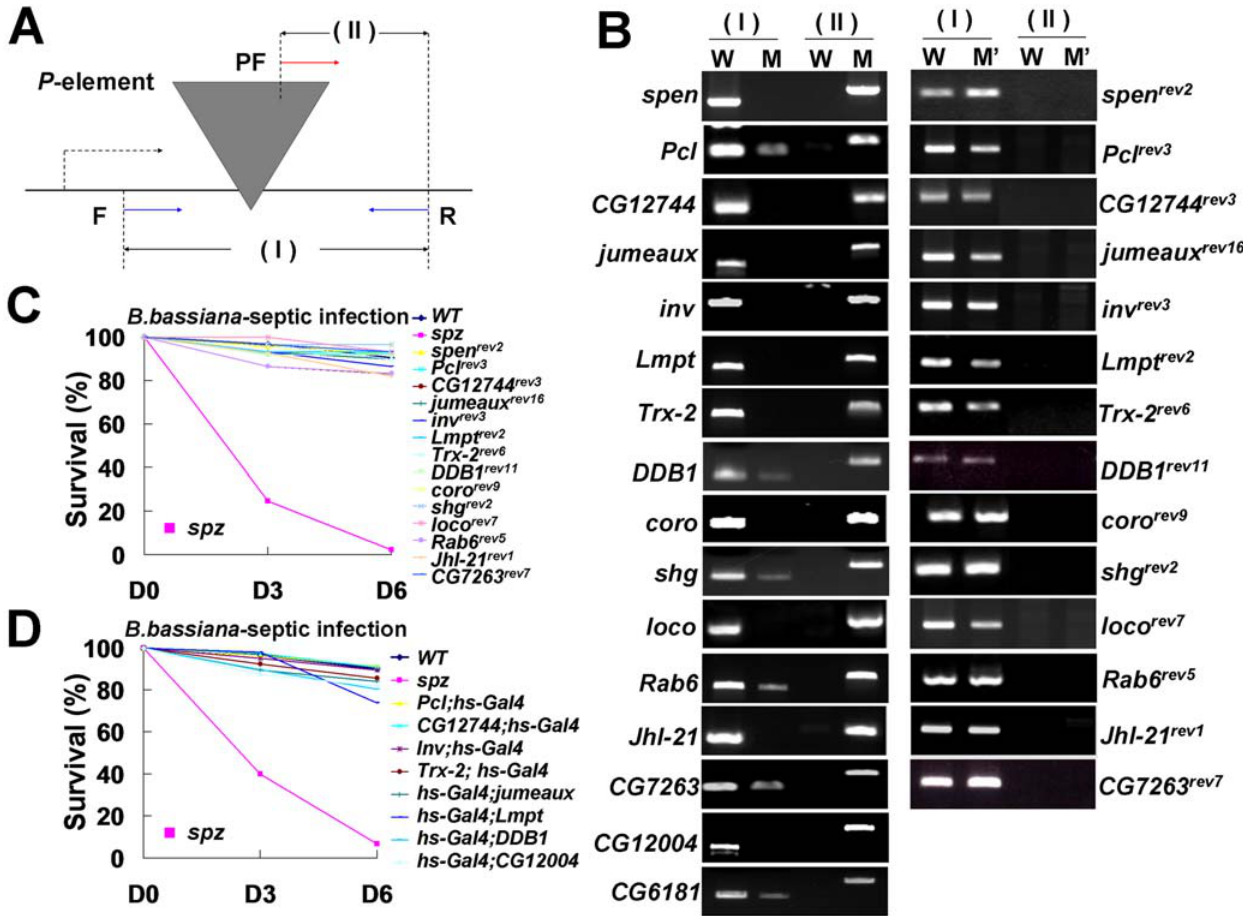
Figure 2. Confirmation of precise excision lines from P -element inserted mutant flies. (A) Relative positions and orientations of PCR primers used to confirm the position of P -element insertions and their precise excision. Primers F and R are complementary to the genomic DNA surrounding each P -element insertion site, while the PF primer is complementary to the P -element. PCR fragments amplified by the gene-specific primers (F and R) or by the P -element- and gene-specific primers (PF and R) are indicated as (I) and (II), respectively. (B) PCR fragments (I) and (II) amplified from wild type (W) or mutant (M) flies are shown in the left panel. The right panel shows corresponding PCR fragments amplified from the precise excision lines (M’) of each mutant. Names of the specific precise excision alleles used in the analysis are indicated at the right. Survival kinetics of the precise excision lines (C) and the flies overexpressing wild type transgenes in mutant background (D). The spz rm7 mutant was used as a positive control for B. bassiana